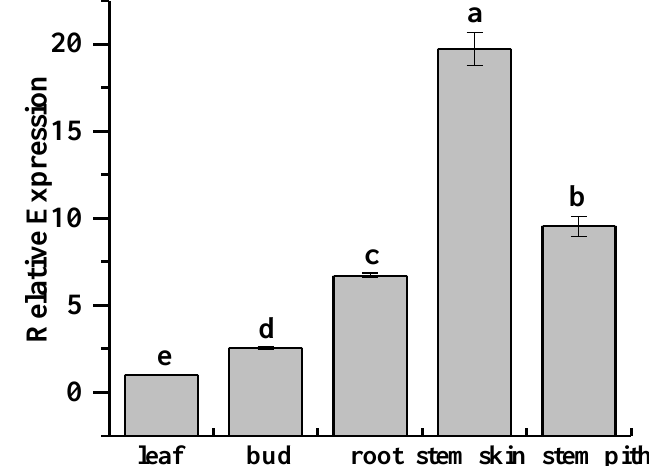
Figure 5. Tissue-specific expression analysis of ScCAT2 in 10-month-old sugarcane Yacheng05-179 plants. Data were normalized to the expression level of the glyceraldehyde-3-phosphate dehydrogenase ( GAPDH ) gene. All data points were expressed as means ± standard error ( n = 3). Different lowercase letters indicated a significant difference ( p < 0.05) compared to the control, as determined with Duncan’s test.